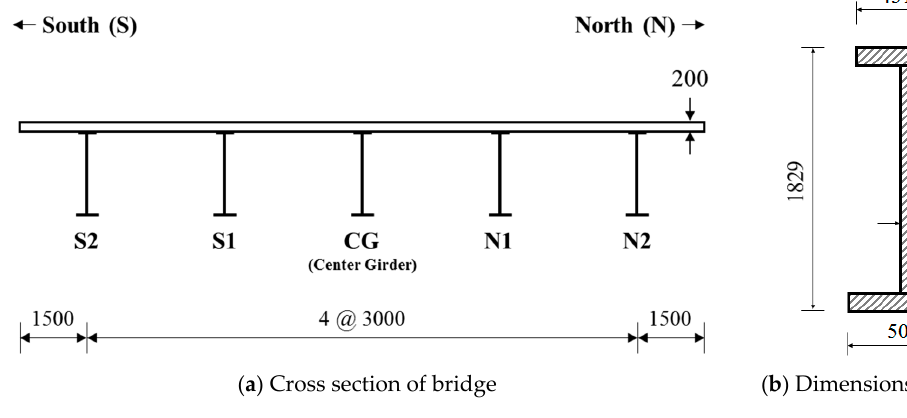
Figure 1. Dimensions of bridge (unit: mm).